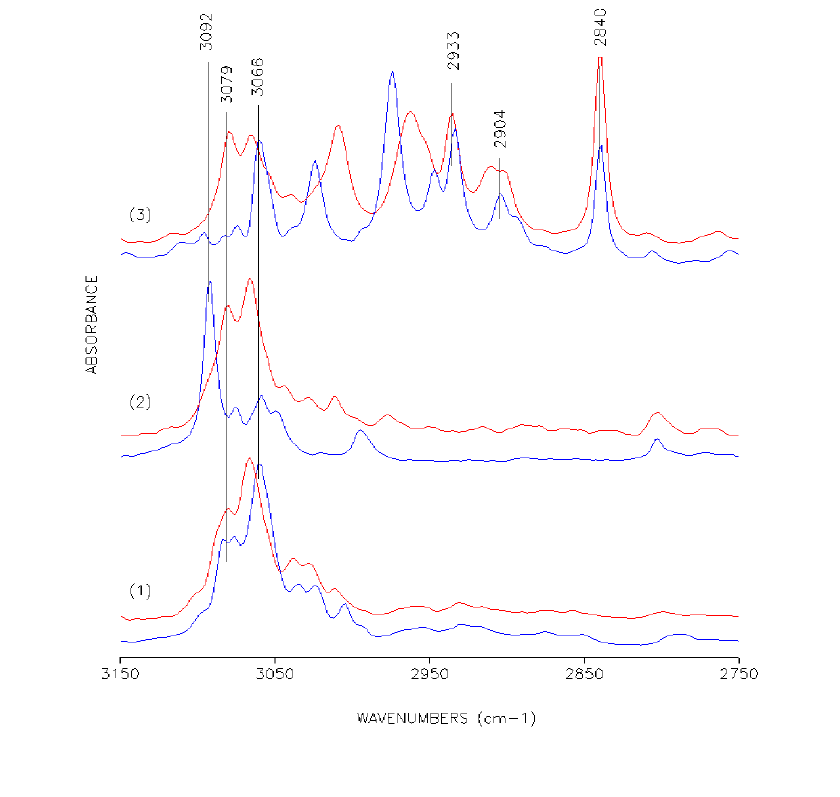
Fig. 3 3150 { 2750 cm ¡ 1 IR spectra of PTB (1), 4’-CNPTB (2) and 4’-MePTB (3); ( ) { in solid state, ( ) { carbon tetrachloride